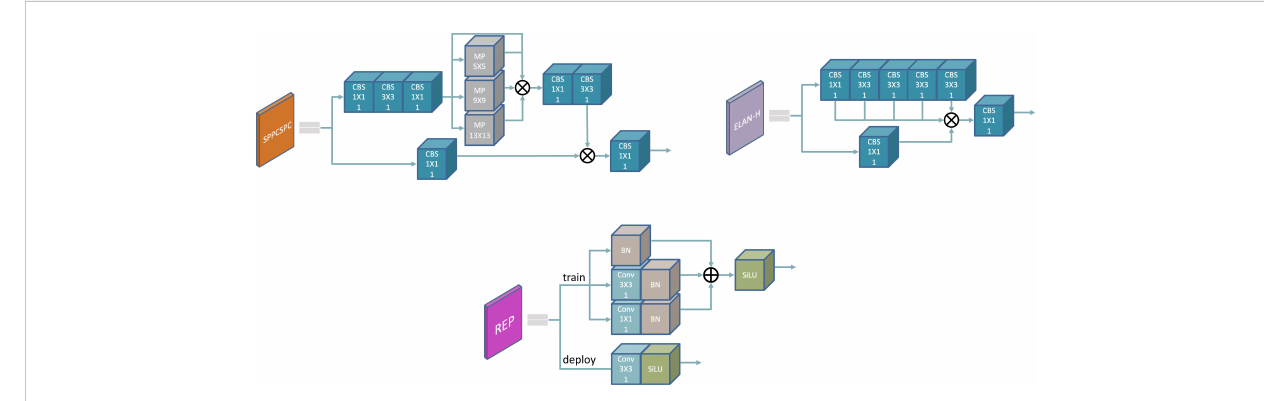
FIGURE 5 Decoder components and REP module ( ⊗ means add